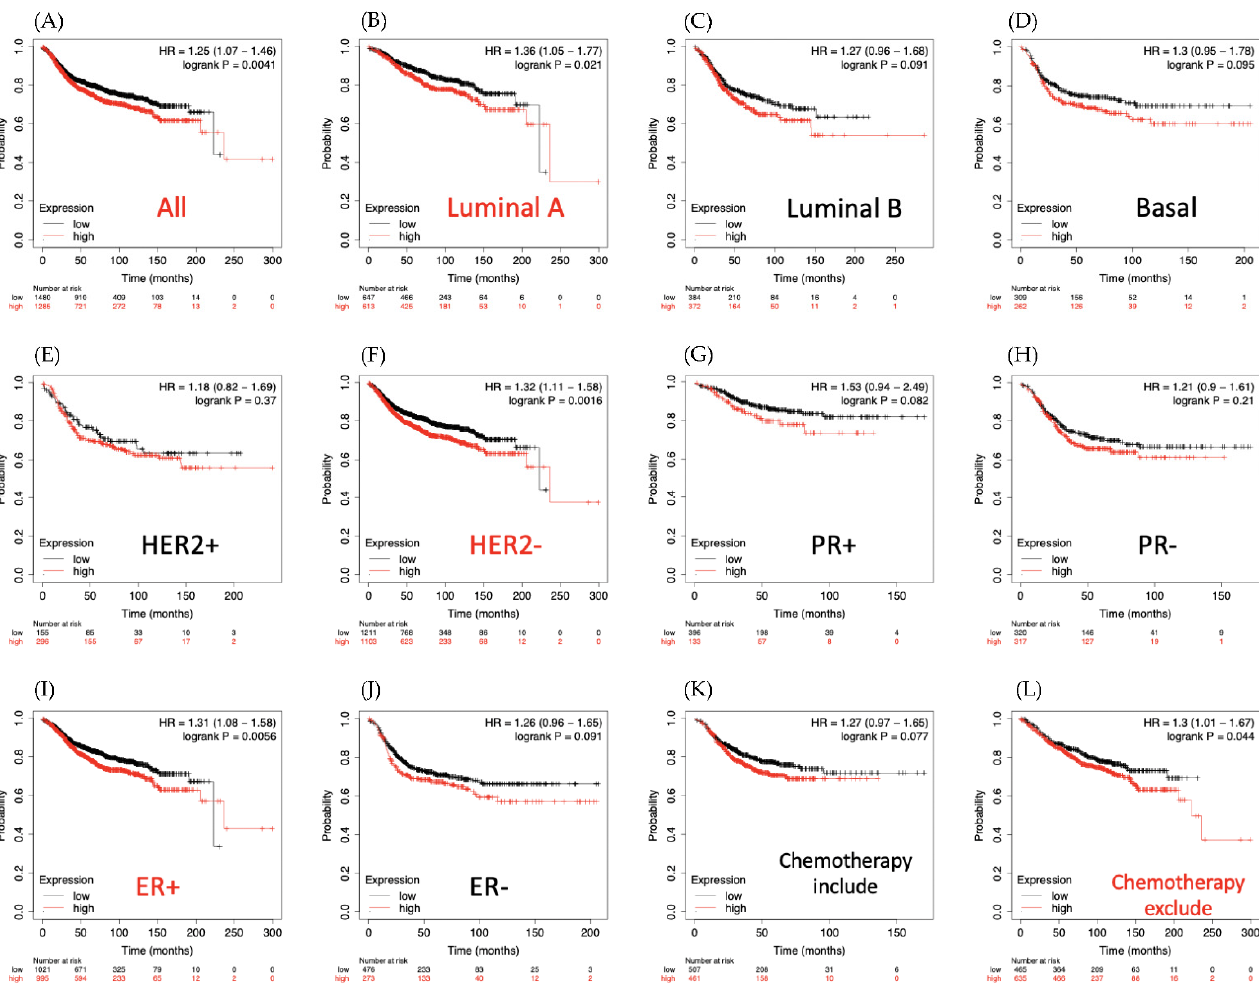
Figure 3. Distant metastasis-free survival (DMFS) analysis of L-antigen 1 (LAGE1) expression of clinical breast cancer cases. Kaplan-Meier plots, which are based on LAGE1 mRNA expression levels, displayed the DMFS prognosis of breast cancer patients. ( A ) Overall survival, ( B ) Luminal A subtype, ( C ) Luminal B subtype, ( D ) Basal subtype, (E) HER2 + subtype, ( F ) HER2 − subtype, ( G ) PR + subtype, ( H ) PR − subtype, ( I ) ER + subtype, ( J ) ER − subtype, ( K ) survival analysis for